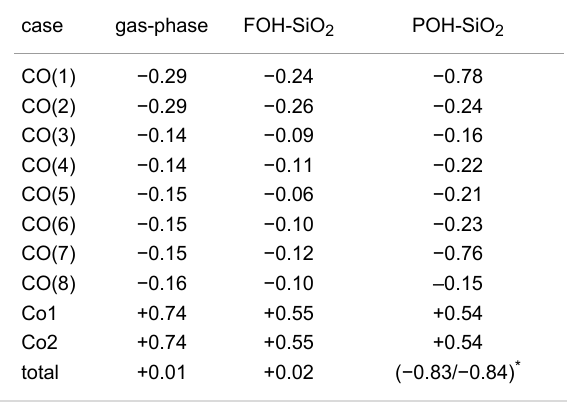
Table 2: Calculated Bader charges for Co 2 (CO) 8 in units of electrons in the gas phase and for the adsorbate on SiO 2 surfaces. The numbers in parenthesis identify the CO ligand as shown in Figure 5a and Figure 7. Values indicated by an asterisk correspond to the